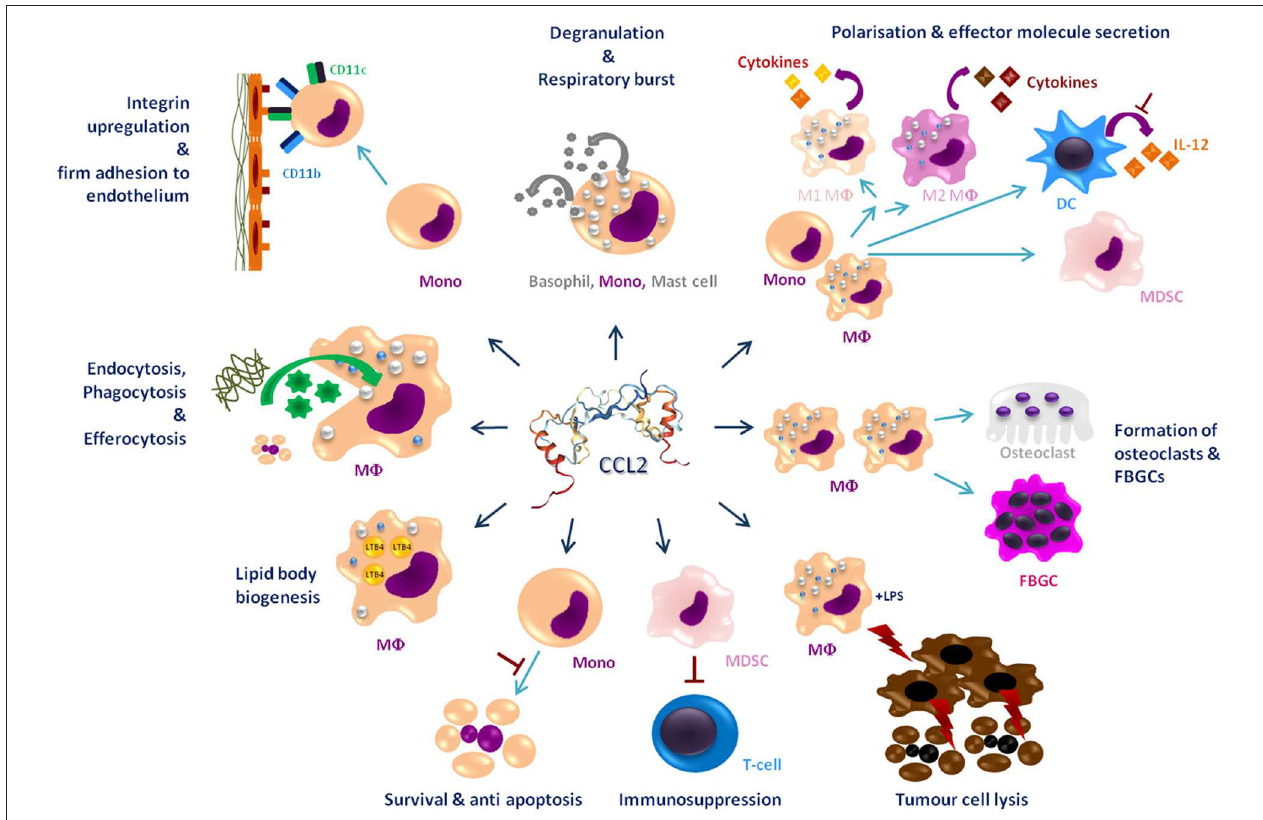
FIGURE 1 | Graphical overview of the effects of CCL2 on myeloid cells apart from migration. CCL2 [structure PDB 1DON (131)] may impact a large number of myeloid cells including, monocytes (Mono), macrophages (M 8 ), dendritic cells (DC), mast cells, osteoclasts, foreign body giant cells (FBGCs), myeloid-derived suppressor cell (MDSC), and basophils. It causes a wide range of different effects on these cells labeled in dark blue headings. Red ⊥ -symbols describe inhibition. Bent arrows describe secretion or intake of molecules; discriminated by the direction of the